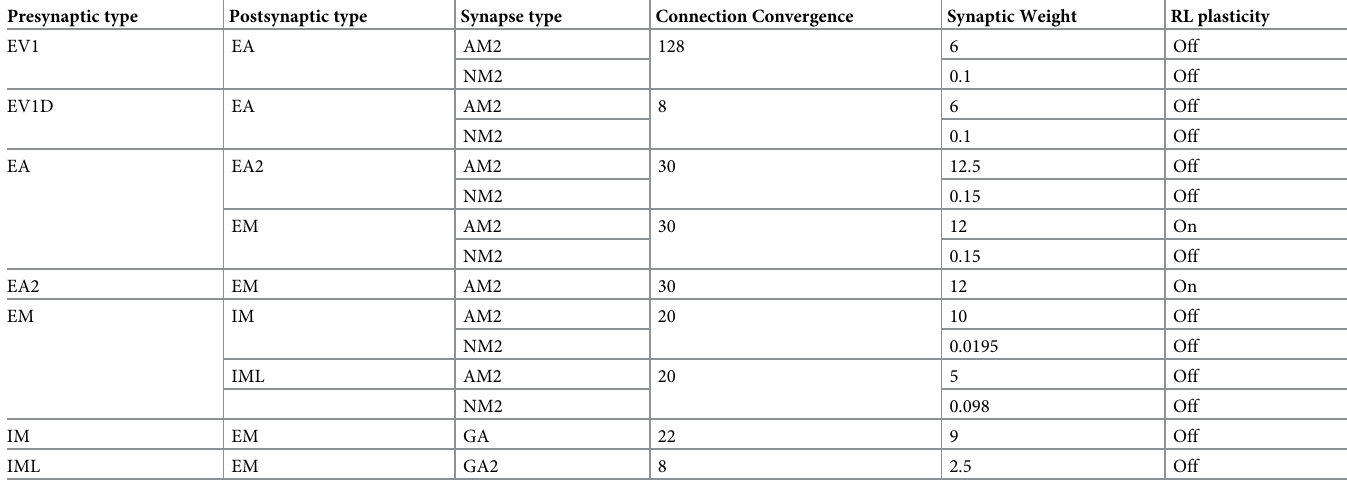
Table 2. Area interconnection probabilities and initial weights for the feedforward model. Presynaptic